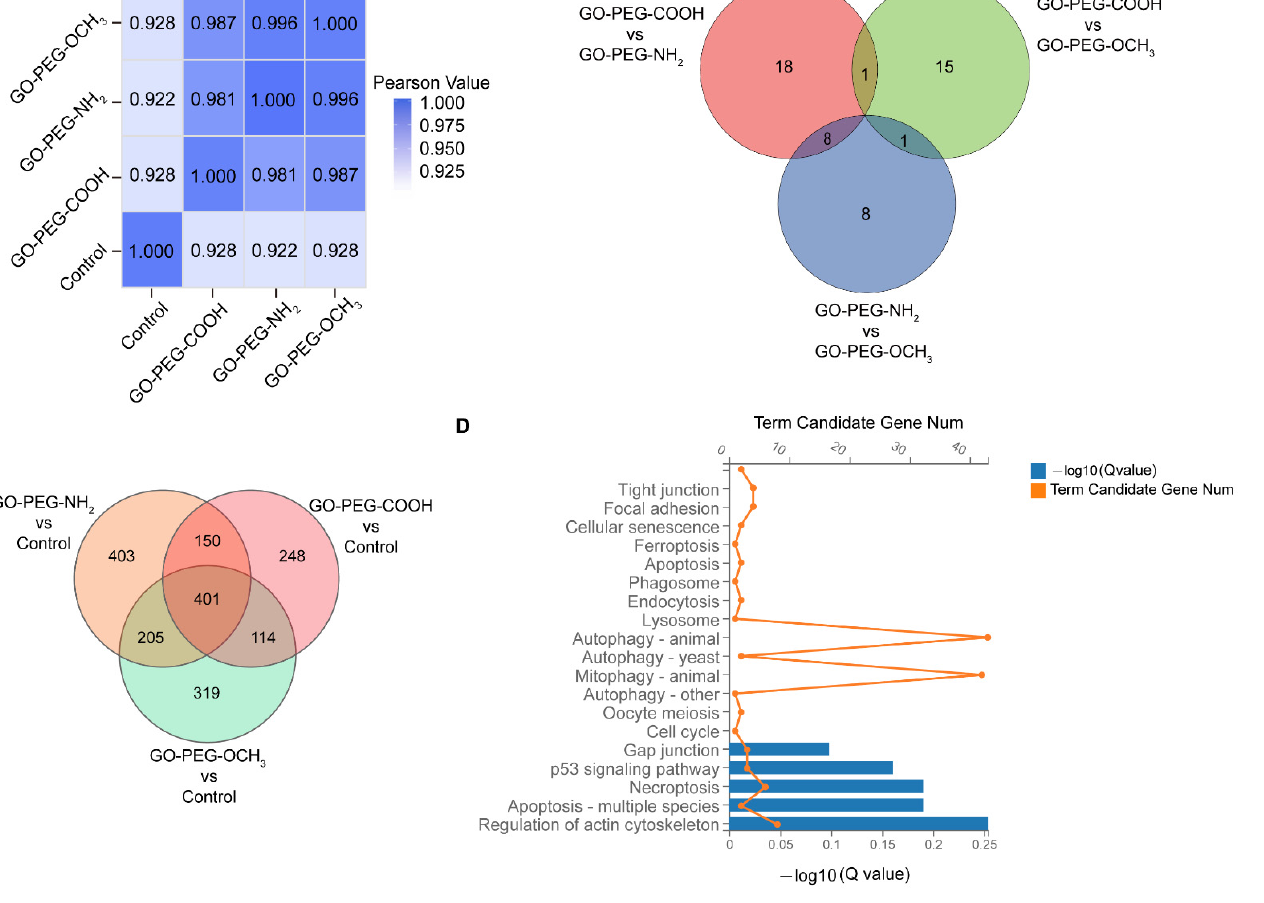
Figure 3. Gene expression profile analysis of hCorECs exposed to PEG-GO nanosheets. ( A ) Pearson correlation analysis of all gene expression in hCorECs of four groups. (GO-PEG-COOH vs. GO-PEG-NH 2 , 0.981; GO-PEG-OCH 3 vs. GO-PEG-NH 2 , 0.996; GO-PEG-OCH 3 vs. GO-PEG-COOH, 0.987; GO-PEG-COOH vs. Control, 0.928; GO-PEG-NH 2 vs. Control, 0.922; GO-PEG-OCH 3 vs. Control, 0.928). ( B ) Venn diagram showed the differentially expressed genes (DEGs) from paired comparisons among three PEG-GO groups. ( C ) Venn diagram showed the DEGs from paired comparisons between PEG-GO groups and control group. Genes with |log2 FC (fold change)| > 1 and adjusted p value ≤ 0.05 were considered to be DEGs. ( D ) The pathway analysis of 401 DEGs in terms of cellular processes based on Kyoto Encyclopedia of Genes and Genomes databases.